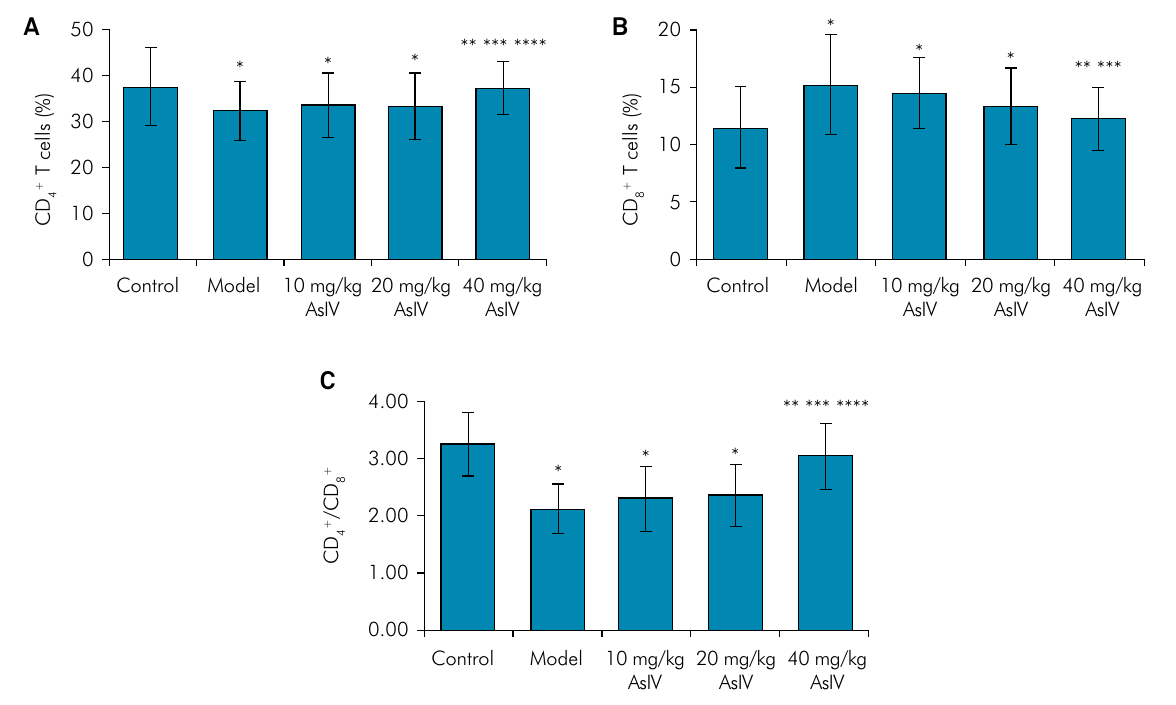
Figure 1. Peripheral blood T lymphocyte subsets in different groups after treatment. A: CD 4+ ; B: CD 8+ ; and C: CD 4+ /CD 8+ ratio. * p < 0.05 compared with the control group; ** p < 0.05 compared with the model group; *** p < 0.05 compared with the 10 mg/kg AsIV group; and **** p < 0.05 compared with the 20 mg/kg AsIV group. AsIV, astragaloside IV.